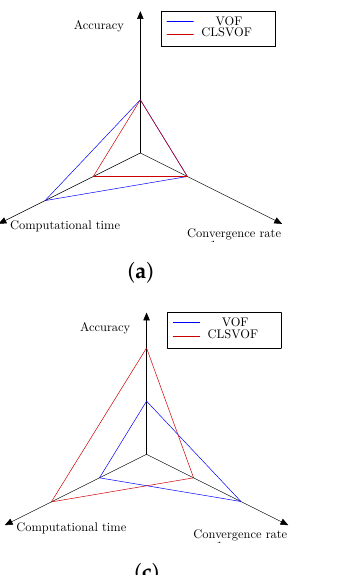
Figure 15. The accuracy, computing time, and convergence rate of the VOF and CLSVOF techniques are shown graphically for four thermally driven phase change benchmark scenarios. Each axis, as indicated, represents a research region and contains two values. If one of the techniques has greater performance in that region, the second value is allocated to that approach, while the first method will receive the first value. ( a ) Stefan problem; ( b ) the condensation by heat conduction; ( c ); 2D vertical film condensation; ( d ) 2D film